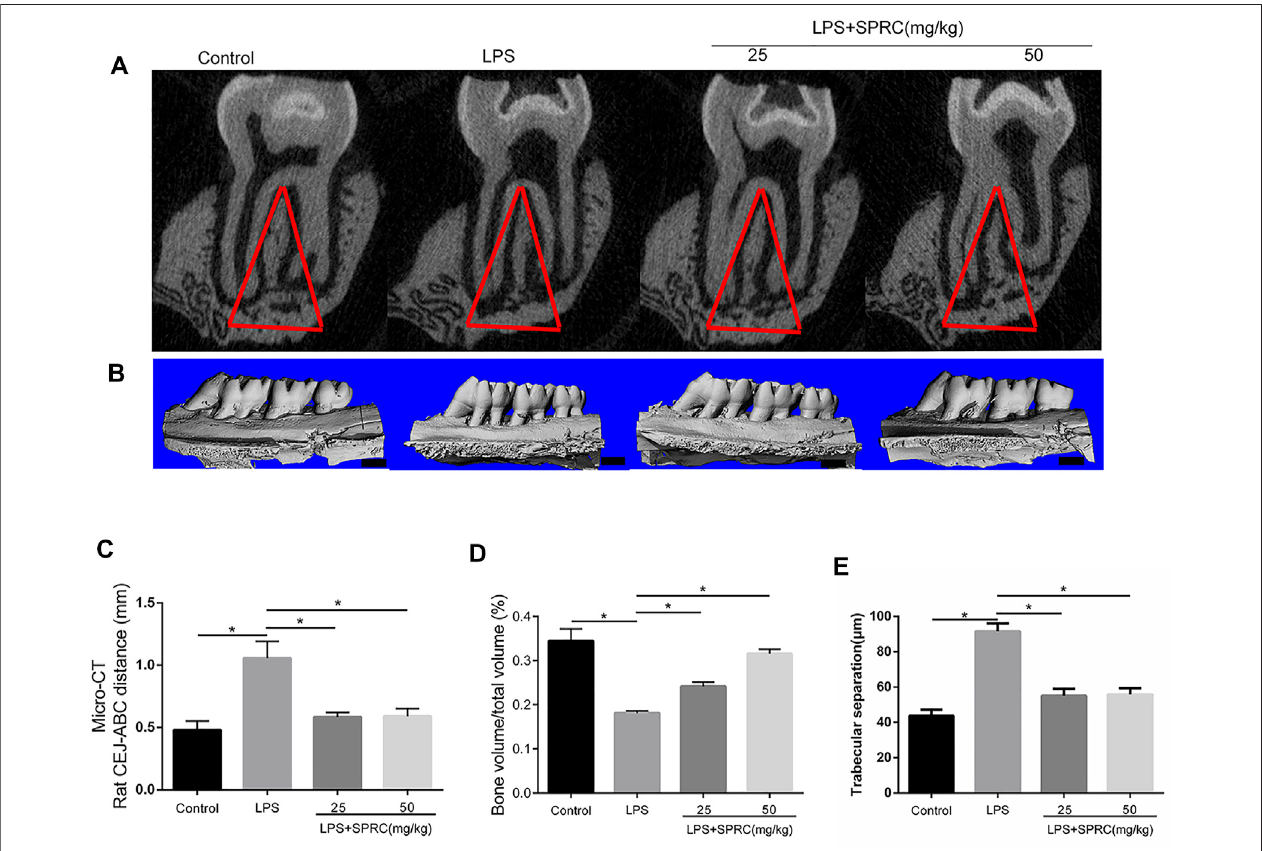
FIGURE 2 | Bone resorption of right maxilla were assessed by micro-CT. (A) Coronal plane of the area under the second molar bifurcation (2D picture)red line indicate region of interest (ROI), (B) Sagittal 3D images (C) CEJ-ABC distance (D) Micro-CT evaluation of the bone volume fraction of the residual alveolar bone in the maxilla(scalebar (cid:1) 100 μ M), (E) Microstructuralparameters ofthetrabecularbone inthemaxilla,trabecular separation(Tb.Sp)(Dataareshownasthemeans ± SDfrom 4 animals vs. LPS